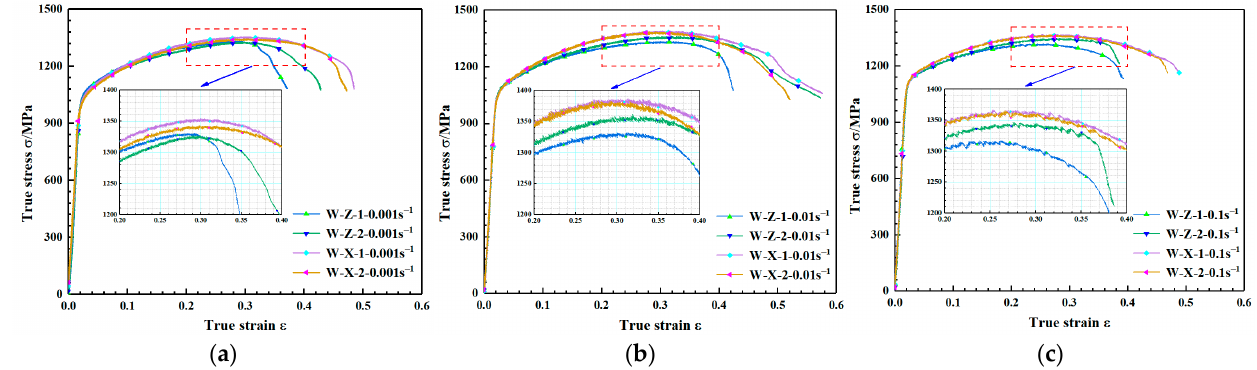
Figure 8. Stress–strain curves for different specimens at the same strain rate under quasi-static loading conditions. ( a ) Strain rate of 0.001 s − 1 . ( b ) Strain rate of 0.01 s − 1 . ( c ) Strain rate of 0.1 s − 1 .